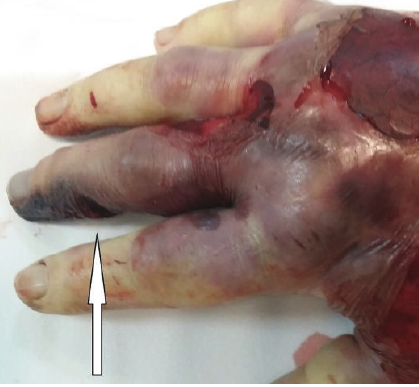
Figure 2: Initial necrotic lesion (white